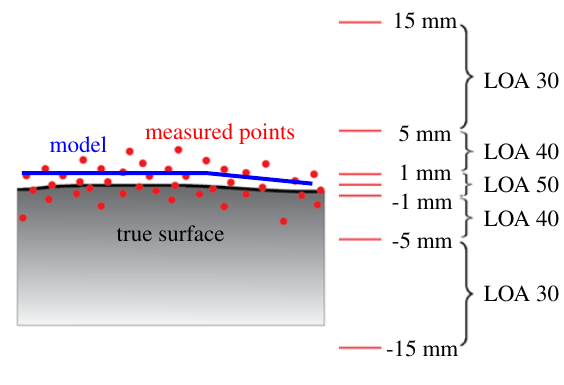
Figure 3. Level of Accuracy (LOA) (USIBD, 2020) for camera pose refinement based on line references, given a coarse orientation (e.g. from IMU (Inertial Measurement Unit) sensors and visual odometry). The stochastic model includes the individual uncertainty information of BIM related objects according to the Level of Accuracy (LOA) specification for BIM (USIBD, 2020) (Fig. 3). The approach will support future developments of image based change detection in indoor envir- onments with available BIM. According to compliance check- ing in BIM, we focus on structural and topological changes in the geometry of BIM compliant 3D